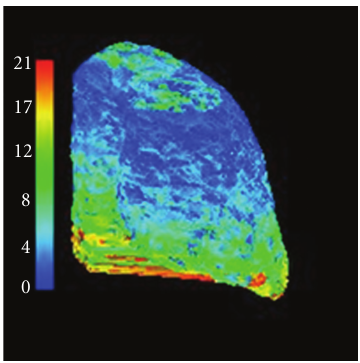
Figure 4: Deformation (mm) along SI direction at the end of